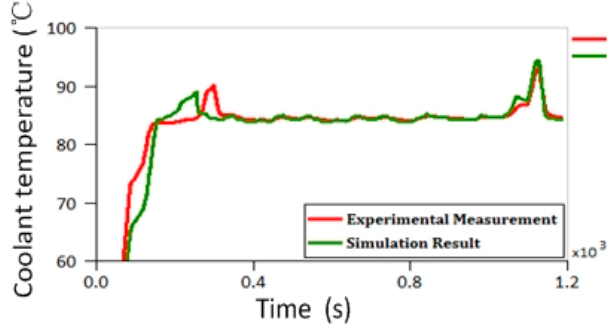
Figure 9. Comparison of the coolant temperature.